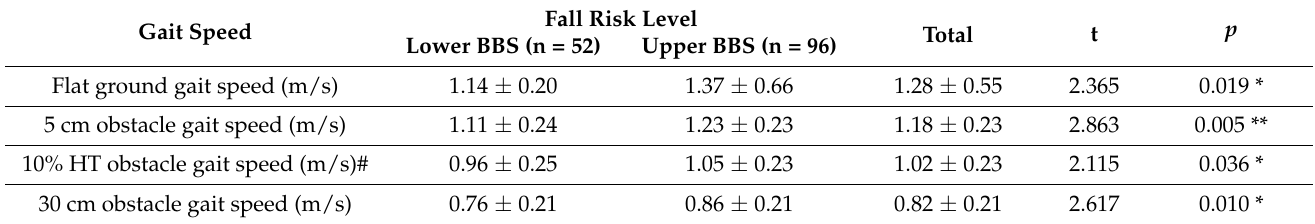
Table 4. Comparison of flat ground and obstacle gait speeds, according to fall risk level (BBS).